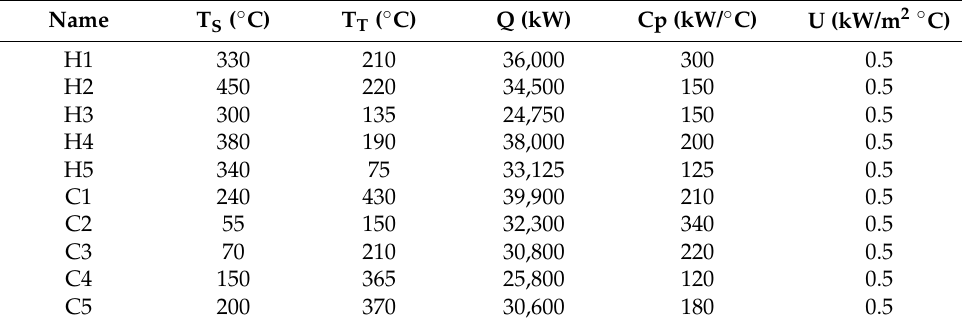
Figure 19. The original structure of HEN. Table 6. Stream data of case study